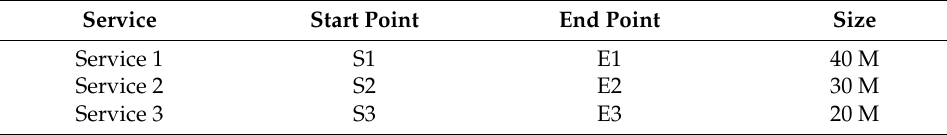
Table 2. Attributes of service